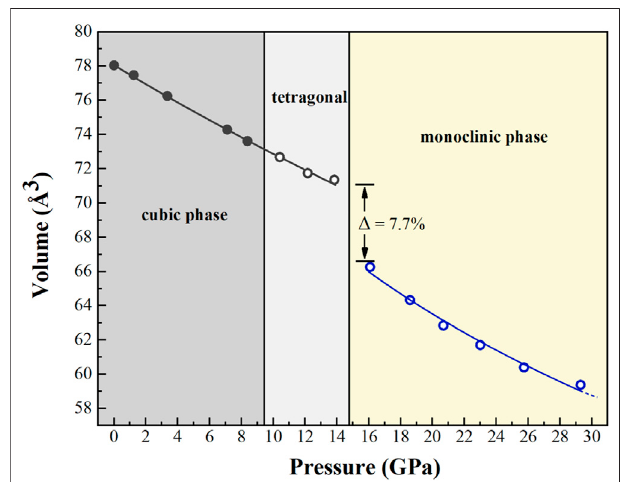
FIGURE 3 | The volume of Cu 2 O as a function of pressure. A volume collapse of 7.7% at about 10.4 – 13.8 GPa, which is the location where the phase transition occurs between the tetragonal and monoclinic